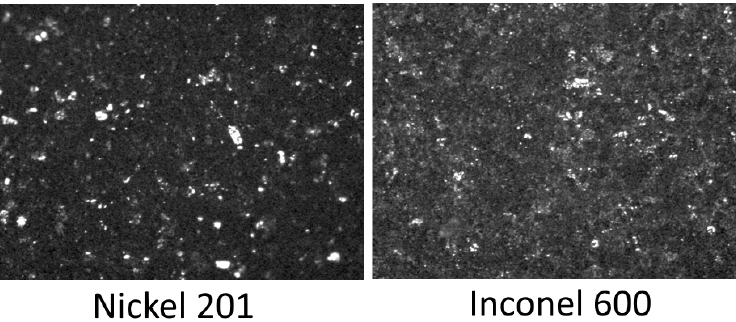
Figure 22. Scanning electron micrographs of the materials used to build the Model III after 43 h long-term test. Magnification: 100×. Materials 2020 , 13 , x FOR PEER REVIEW 19 of 21